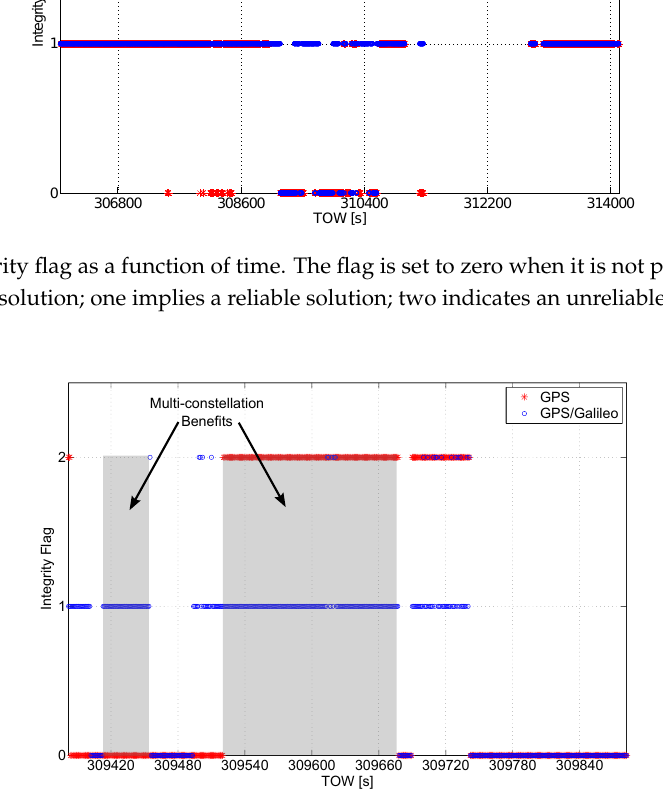
Figure 15. Details of the velocity integrity flag around epochs where the GPS-only solution is declared unreliable.